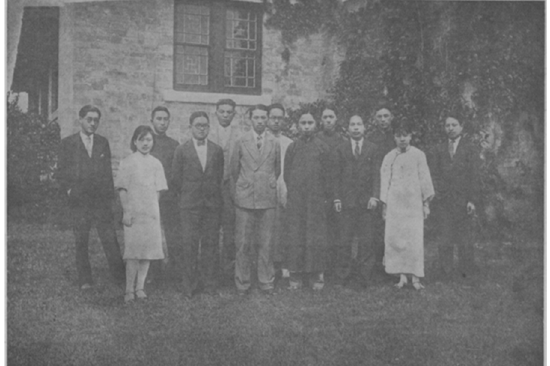
Figure 2. Editorial Board Members of the University of Nanking Magazine.